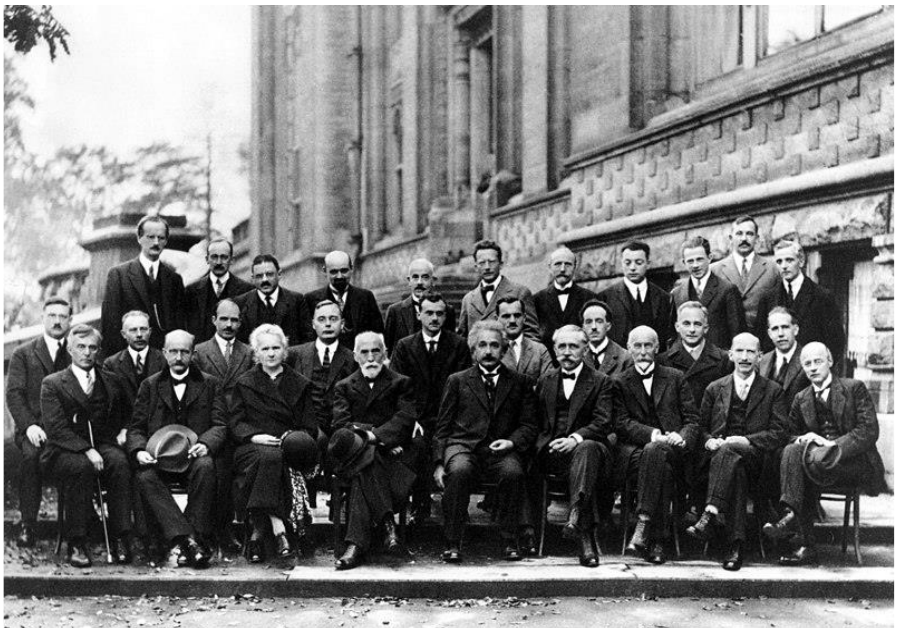
Figure 3. The 1927 Solvay Conference attended by Planck, Mme Curie, Einstein, Dirac, Schrodinger,